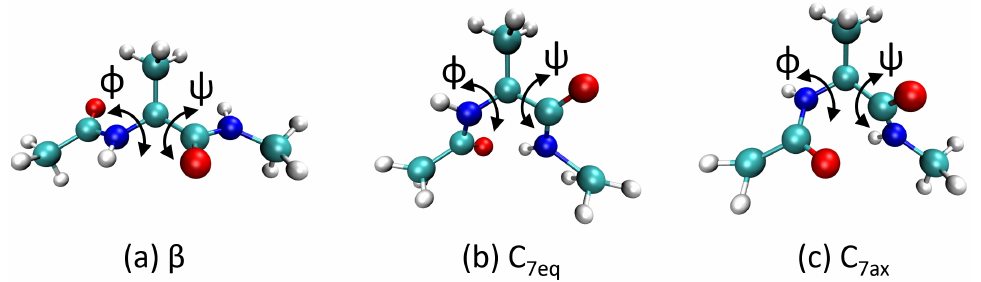
Figure 1. Molecular structures of three metastable minima: ( a ) β , ( b ) C 7eq , and ( c ) C 7 ax of alanine dipeptide, which is composed of 22 atoms. Each panel depicts the two dihedral angles ( φ , ψ ) used to bias and analyze our calculations. The H, C, N, and O atoms are shown in white, cyan, blue, and red,